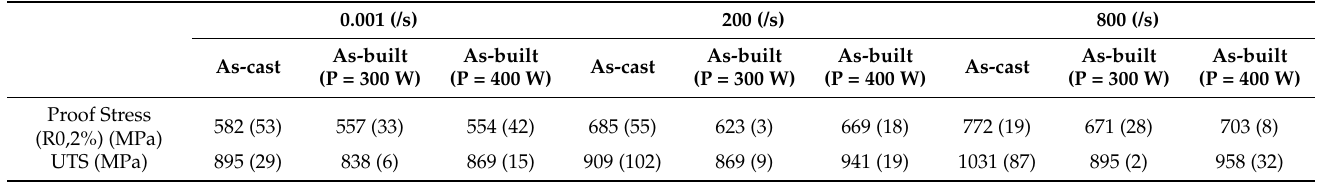
Table 5. Mechanical performance of the as-cast and as-built specimens. Standard deviation is in brackets. 0.001 (/s) 200 (/s) 800 (/s) As-built As-built As-built As-built As-built As-built As-cast As-cast As-cast (P = 300 W) (P = 400 W) (P = 300 W) (P = 400 W) (P = 300 W) (P = 400